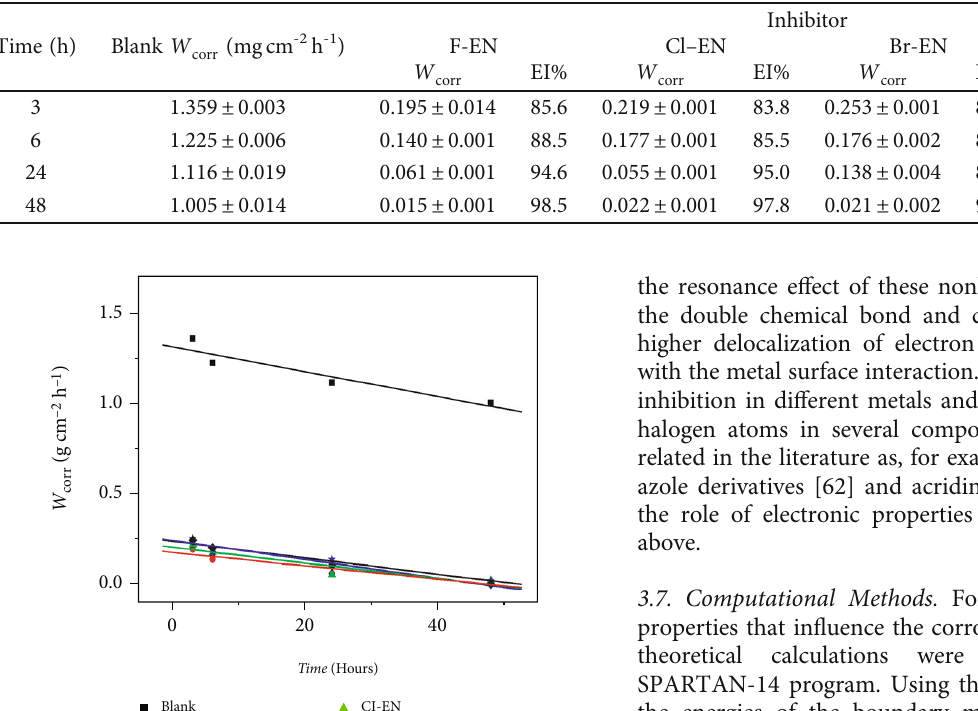
-2 h -1 ) in the absence and presence of corr /mgcm